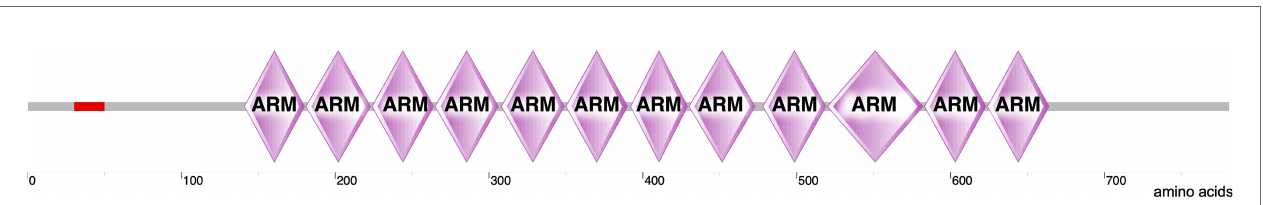
FIGURE 1 | Structure of b -catenin. The structure of b -catenin was generated by SMART (http://smart.embl-heidelberg.de/smart/show_motifs.pl?ID=P35222) and modi fi ed using Canvas X draw. It includes an N-terminal domain where several regulatory phosphorylation sites are located (red). This domain follows twelve ARM domains and a long C-terminal